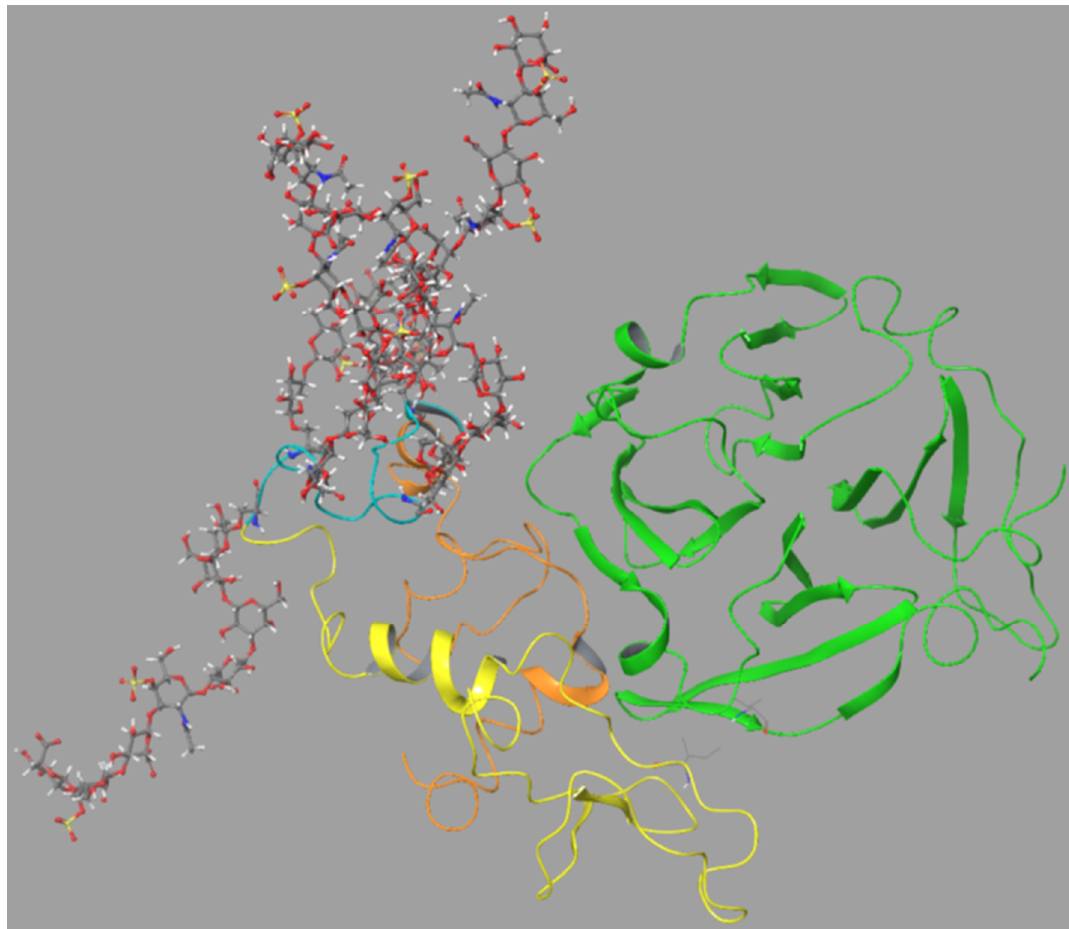
Figure 11. SG docked to the MMP-9-HPX domain, Model 2: The SG core protein was docked into the MMP-9-HPX domain using the BioLuminate program as described in the Materials and Methods. The HPX domain is labelled in light green, and the SG core protein with attached CS chains is labelled as in Figures 8 and 9. Table 3. Amino acid interactions between HPX and SG as seen in Model 2. Amino acid interactions between HPX and SG based on peptide arrays, docking, and MD simulations.